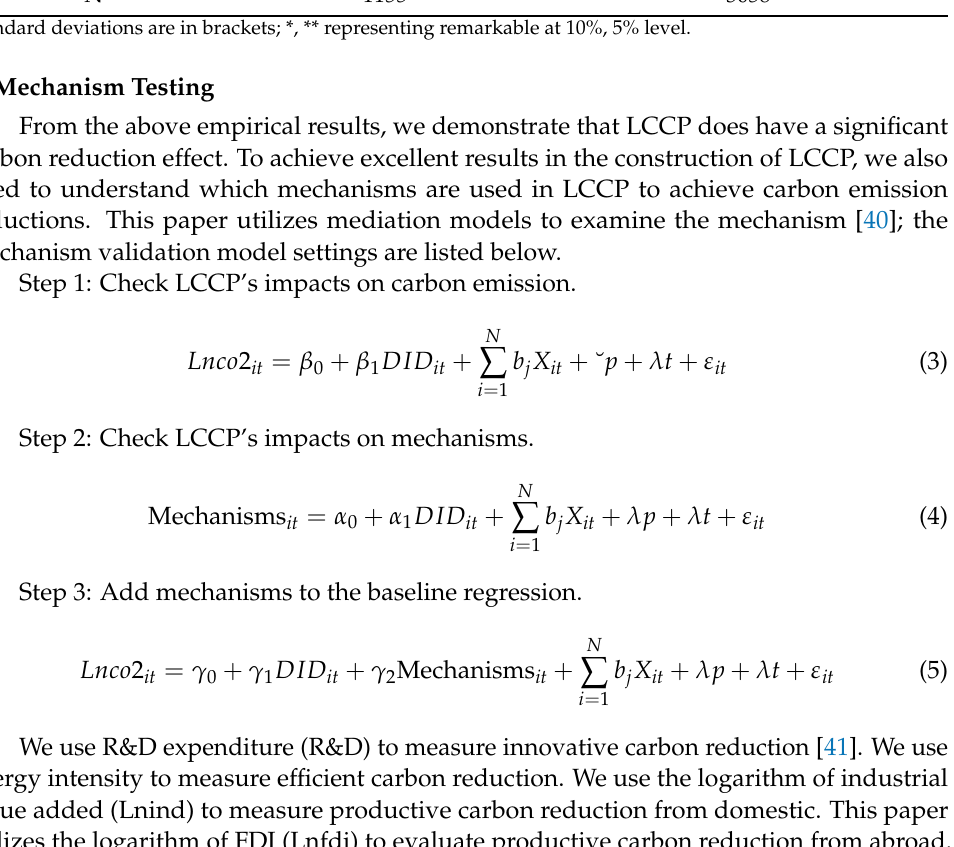
Table 10. Eliminate other policy distractions. LnCO 2 So2 Emission Trading Pilot Air Pollution Key Control Area DID − 0.036 * (0.010) Control Variable Yes Yes City